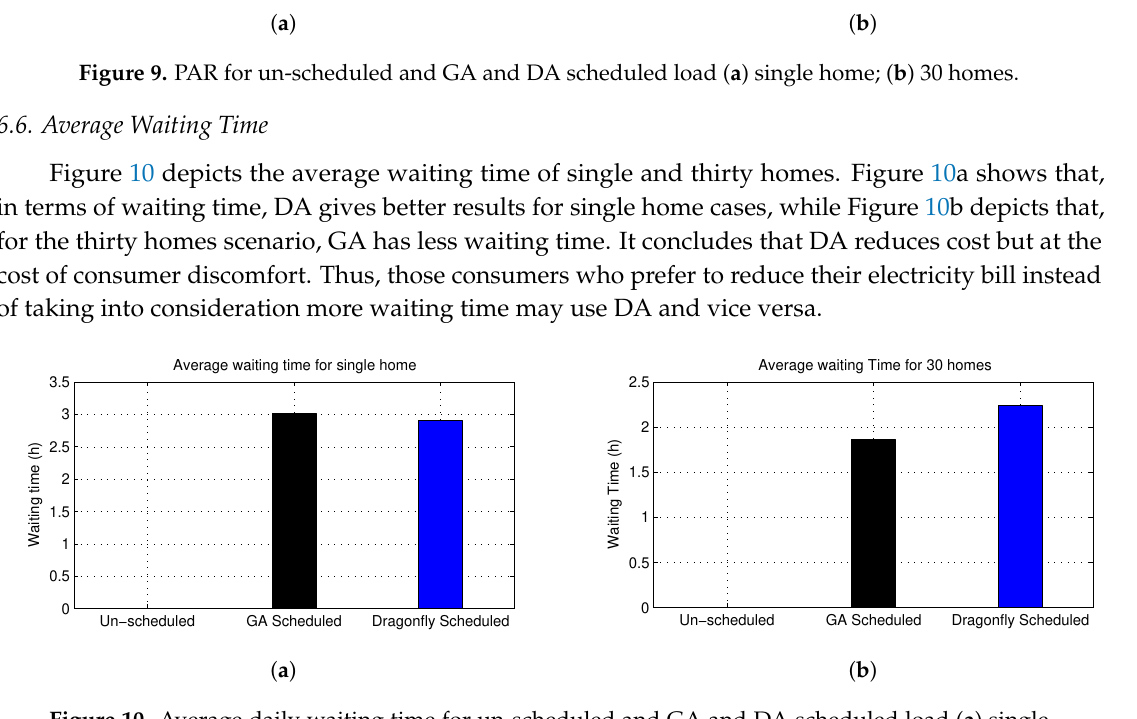
Figure 10. Average daily waiting time for un-scheduled and GA and DA scheduled load ( a ) single home; ( b ) 30